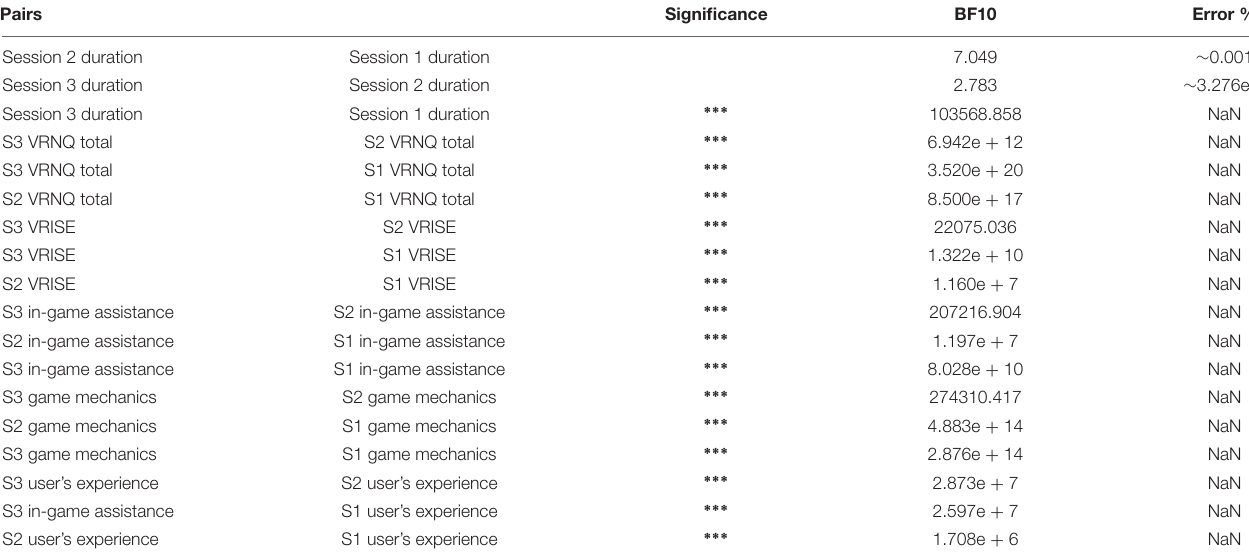
TABLE 6 | Bayesian paired samples t -tests: differences between the VR software. Pairs